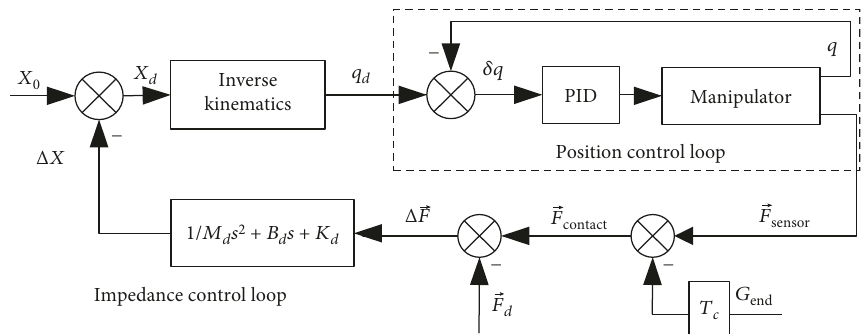
Figure 16: Flowchart of the impedance